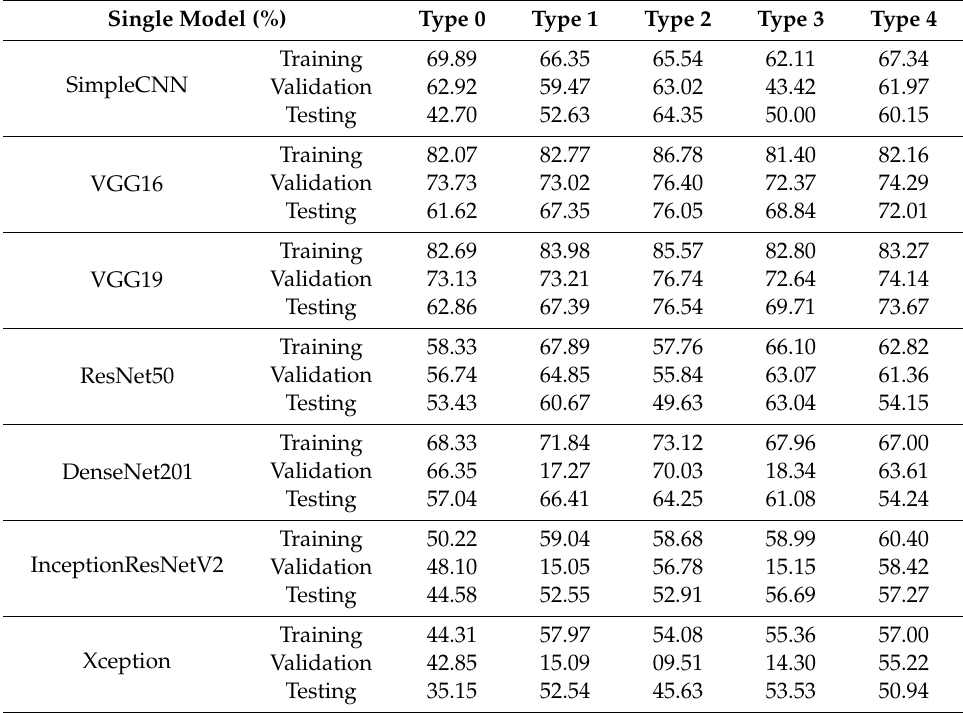
Table 7. Classification performance of the CNNs with data augmentation under transfer learning (11